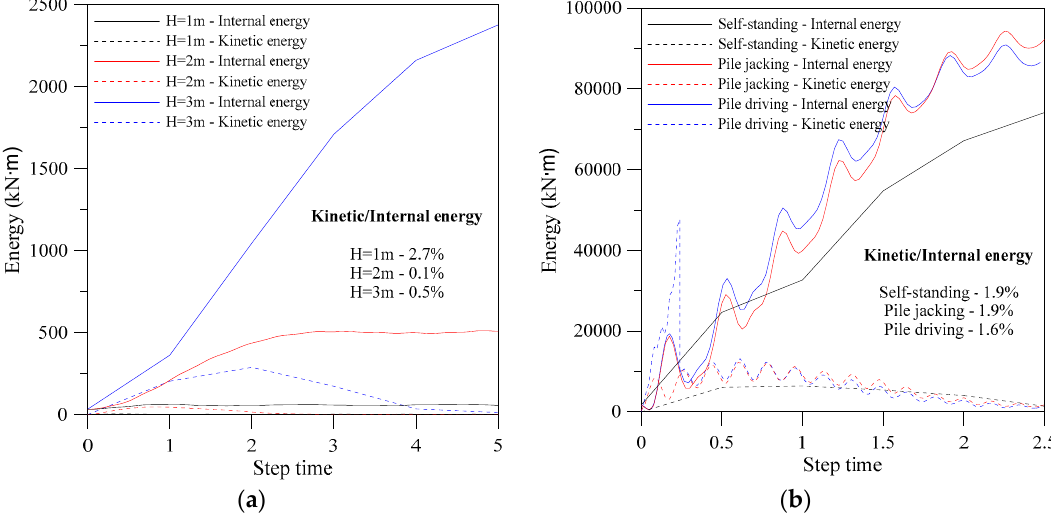
Figure 16. Comparison of internal and kinetic energies: ( a ) Forced replacement method; ( b ) pile installation on deep mixing soil.